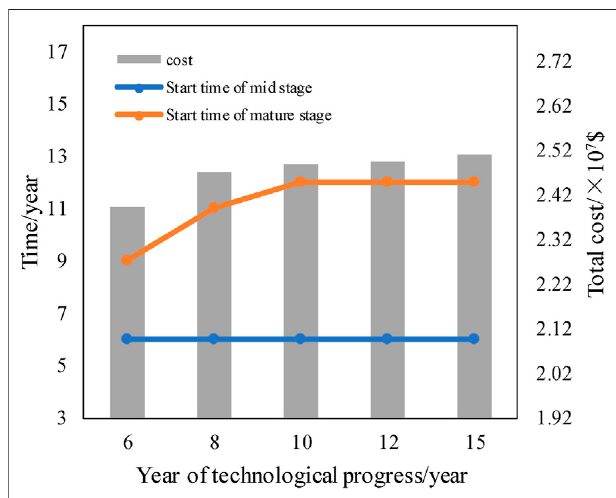
FIGURE 12 | Impact diagram of technological impact